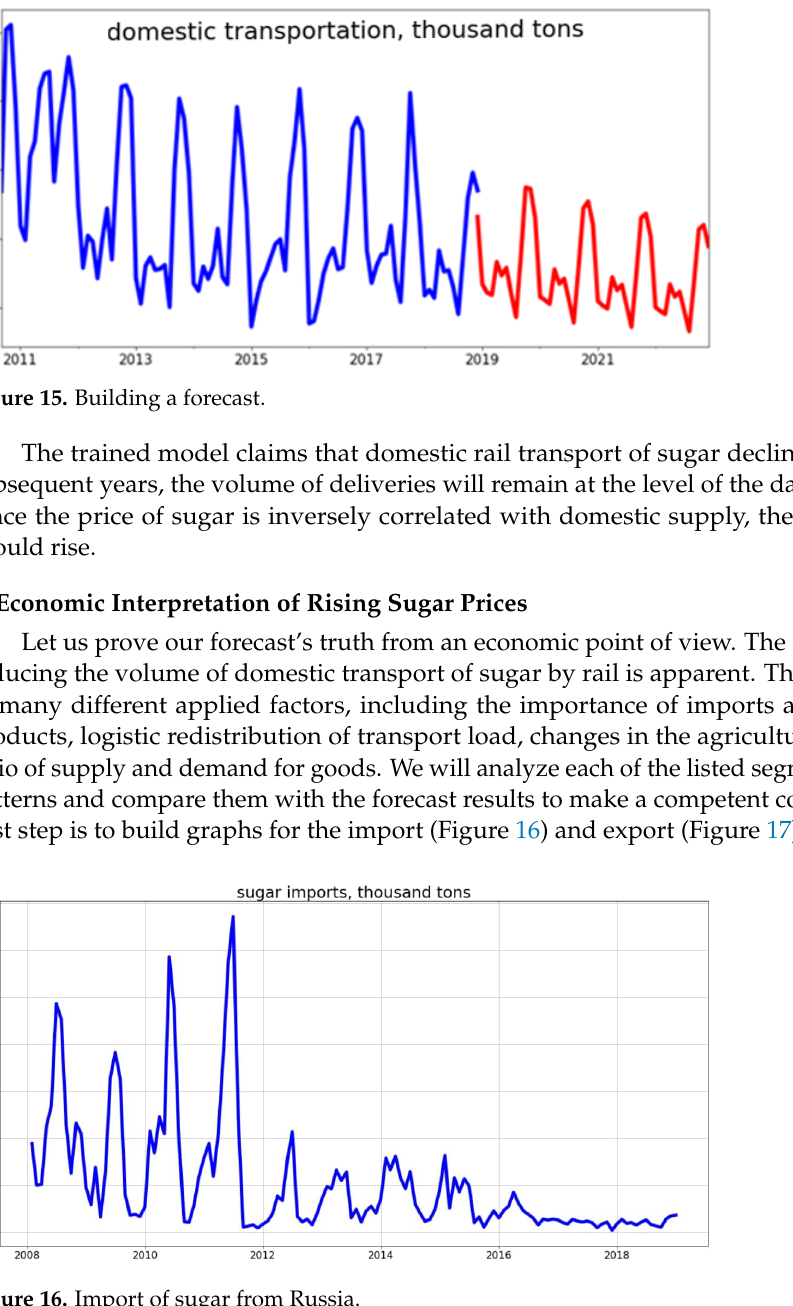
Figure 16. Import of sugar from